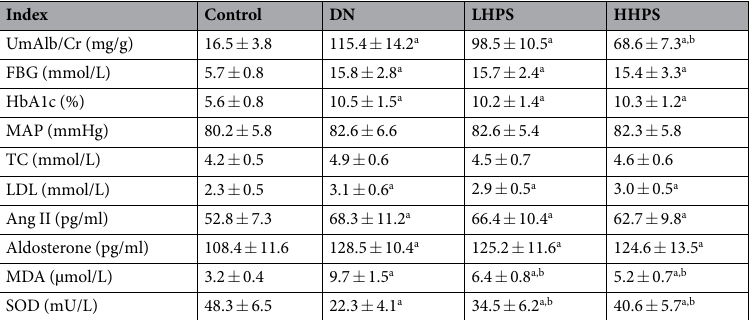
Table 1. The effect of hyperoside pre-treatment on proteinuria, glucose and lipid metabolism, blood pressure, serum RAS and ROS in DN mice (n = 15). Control: Normal mice; DN: DM mice were treated with vehicle solution; LHPS and HHPS: DM mice were treated with 10 or 30 mg/kg/d hyperoside for four weeks from two weeks after DM establishment respectively. Data are presented as mean ± SD. P < 0.05 is statistically significant. a Indicates significant vs. Control, b indicates significant vs.